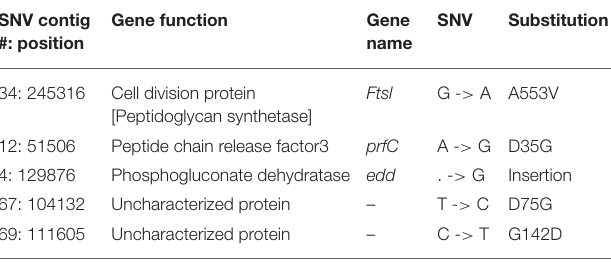
TABLE 3 | SNVs from Korea outbreak strains that are distinct from the Philippine